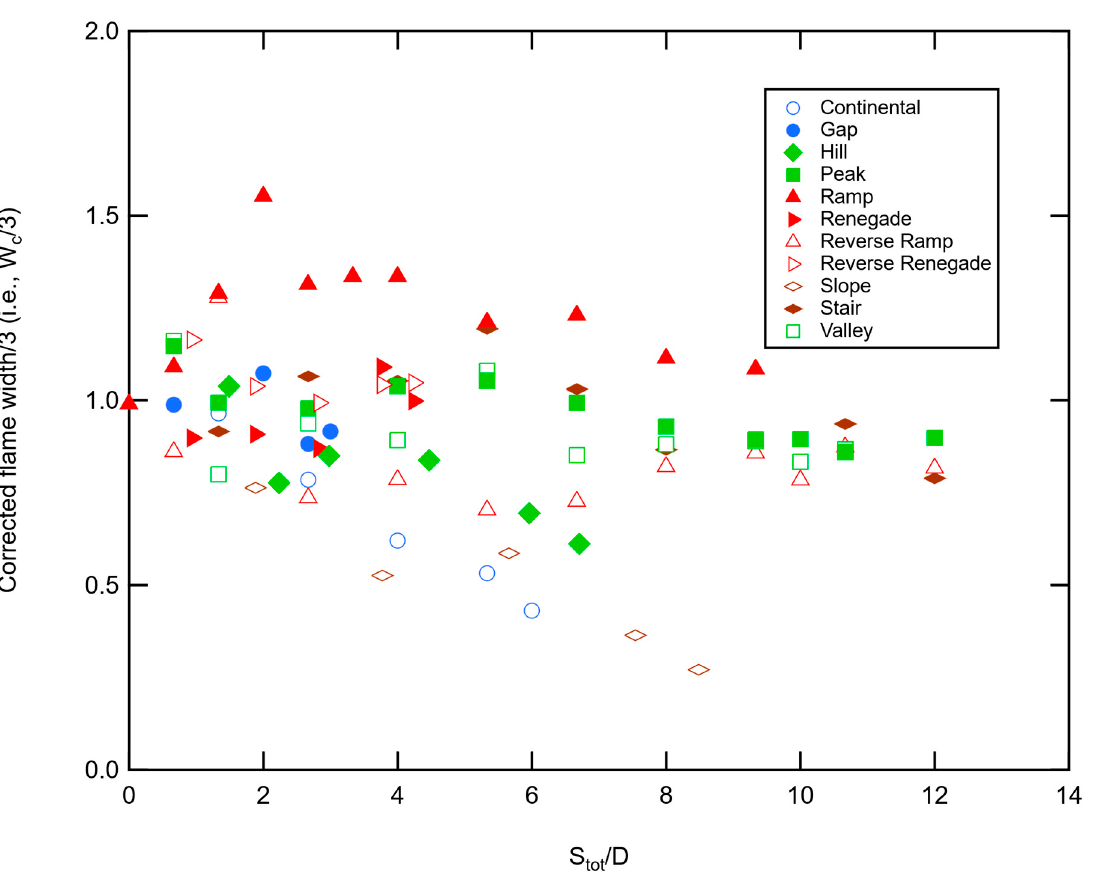
Figure 16. Corrected flame width ( W c ) vs. normalized total separation distance ( S tot /D ) from experiments with three pads. Flame widths normalized by three times the width of a single pad. Configurations are shown in Figure 2.